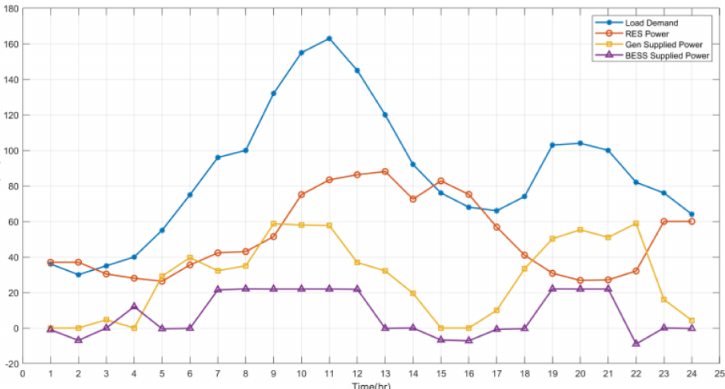
Figure 9. Power dispatched by the microgrid in Scenario